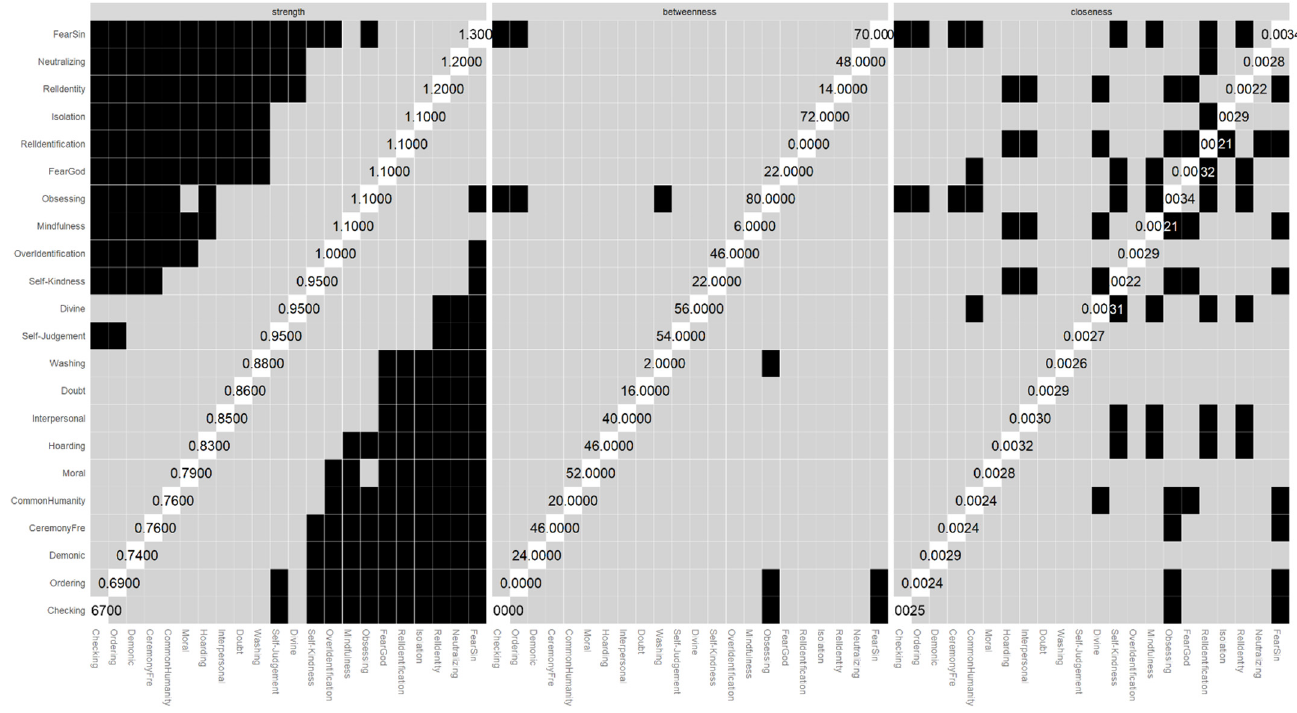
Figure A4. Differences in centrality of nodes.